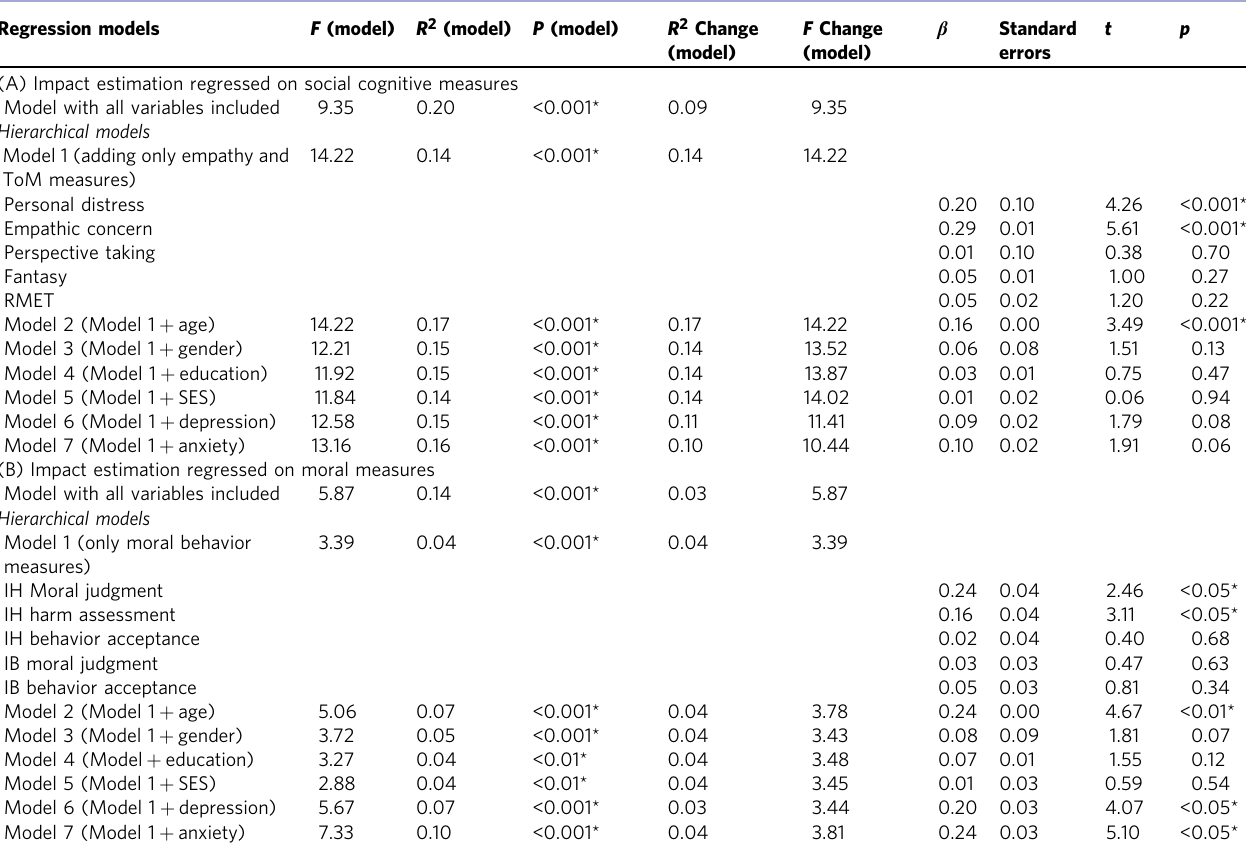
Table 3 Regression models on impact estimation. Regression